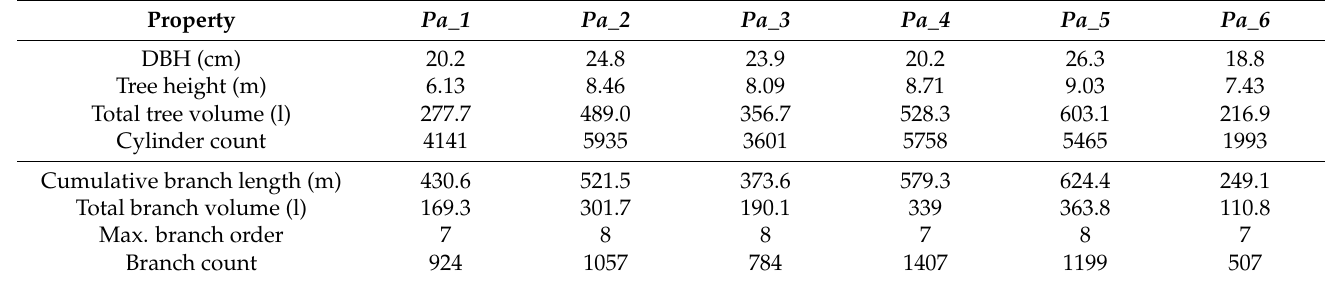
Table 2. Quantitative structure models (QSM)-derived tree parameters for the six sampled wild cherry